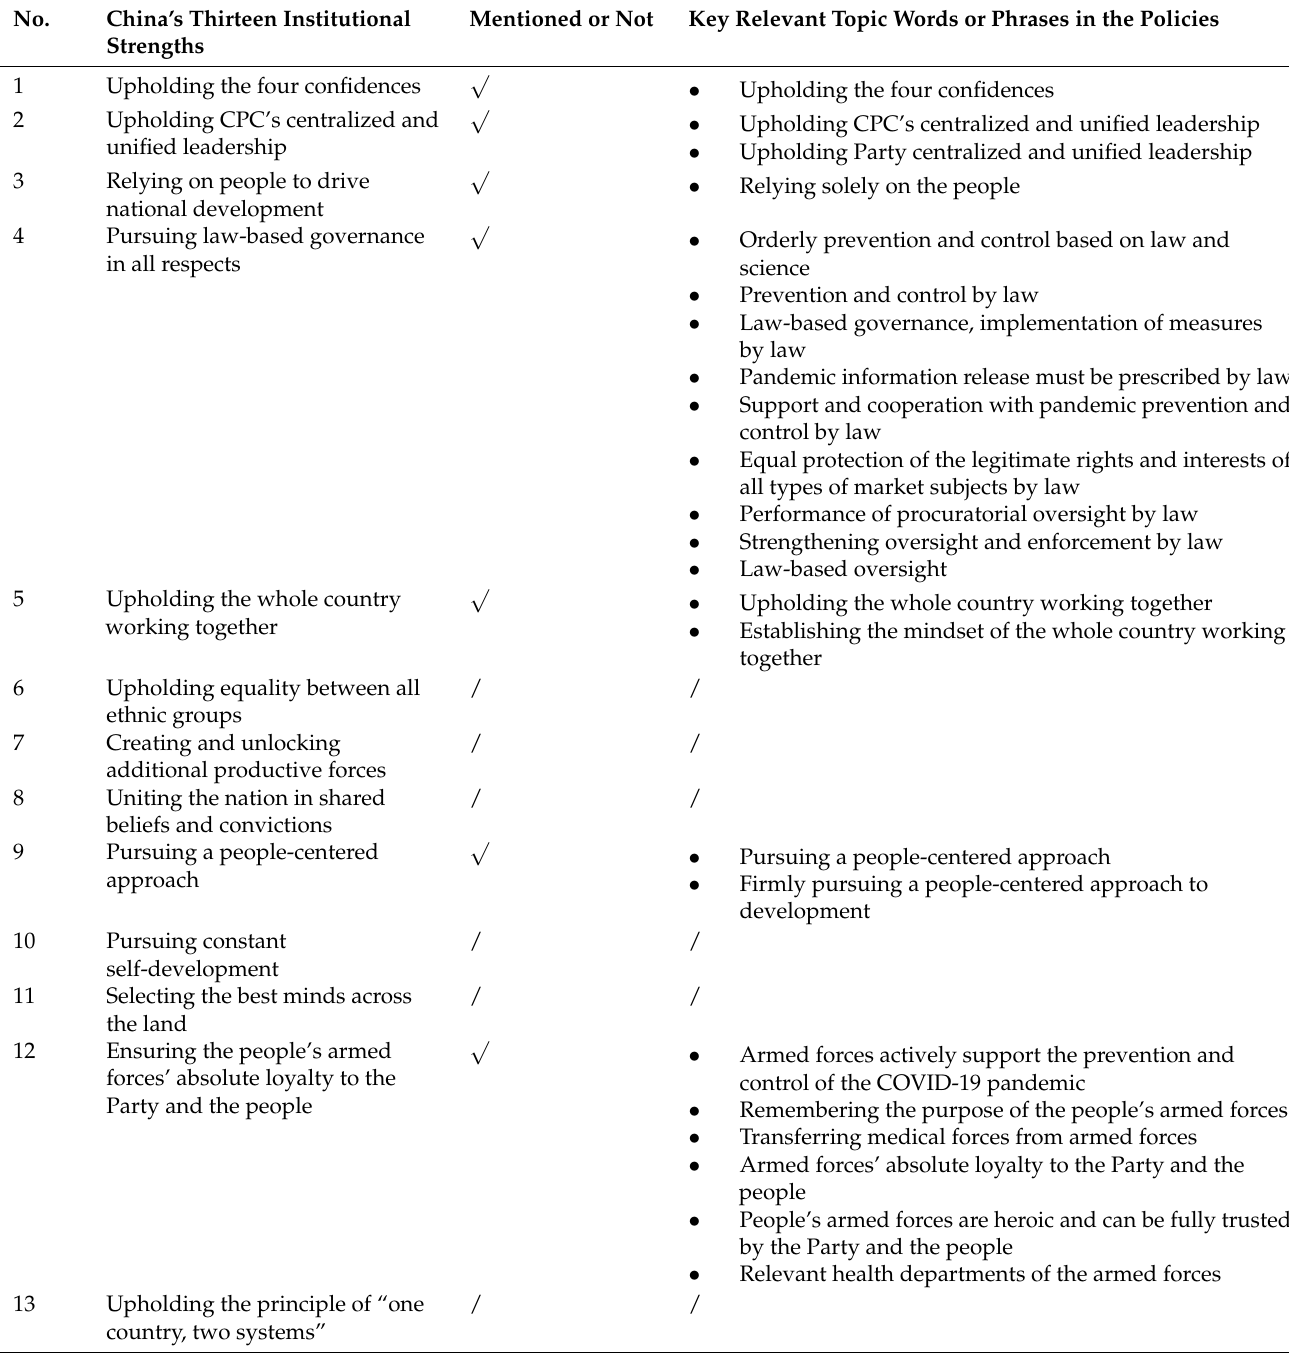
Table 4. Institutional strengths in COVID-19 prevention and control policies.. Key Relevant Topic Words or Phrases in the